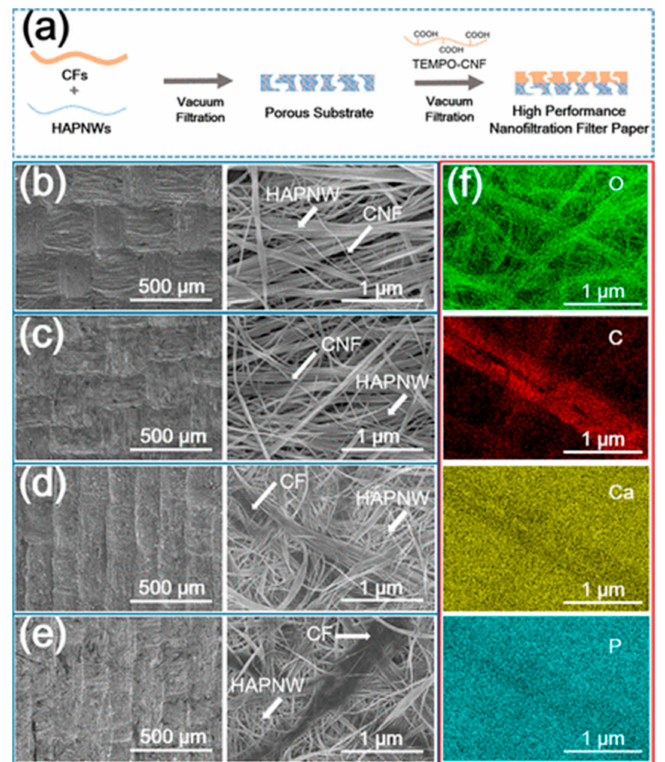
Figure 7. ( a ) Schematic illustration for the preparation process of the membrane: CFs (cellulose fibers), HAPNWs (ultralong HAP nanowires). ( b – e ) SEM images of the memebrane with different cellulose weight ratios: ( b ) 20 wt% CNFs; ( c ) 40 wt% CNFs; ( d ) 20 wt% CFs; ( e ) 40 wt% CFs. ( f ) Energy dispersive spectroscopy mappings of the filter with 20 wt% CFs., showing the distribution of O, C, CA and P elements in the filter. With permission from ACS Publications. https://doi.org/10.1021/ acssuschemeng.9b03793 (accessed on 14 April